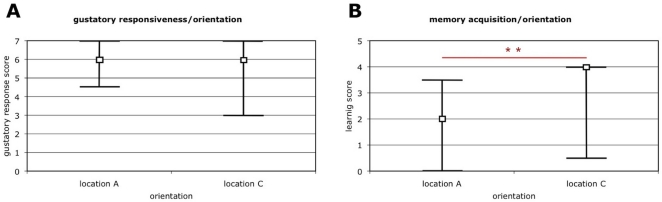
Deficits in olfactory learning predict lack of intact extinction performance.(A) No association between sensitivity to sucrose (US) and orientation behavior was found. (B) In contrast, reduced olfactory learning ability, a population-level characteristic of old foragers (Fig. 1A,B), is a predictor of orientation behavior in a cohort comprising mixed-age forager groups. Workers that oriented towards a novel location C had the higher median learning ability, outperforming the workers that oriented towards location A, the location bees were trained to extinguish. Graphs indicate medians and interquartile ranges, the asterisk denotes significance (Kruskal-Wallis test).